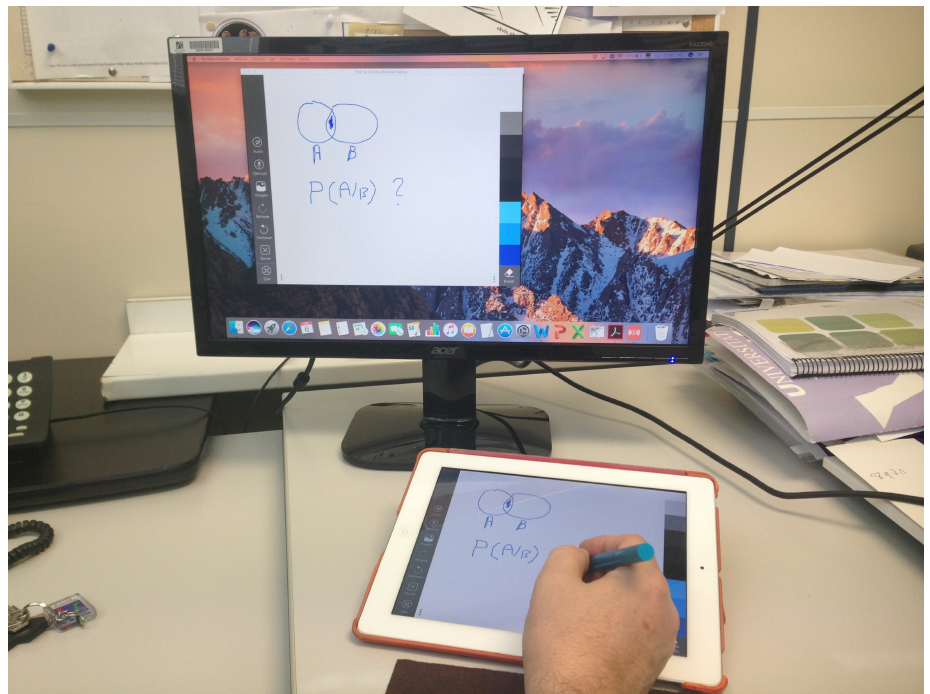
Figure 5. Communication between teacher and student via videoconferencing by using a tablet and computer.